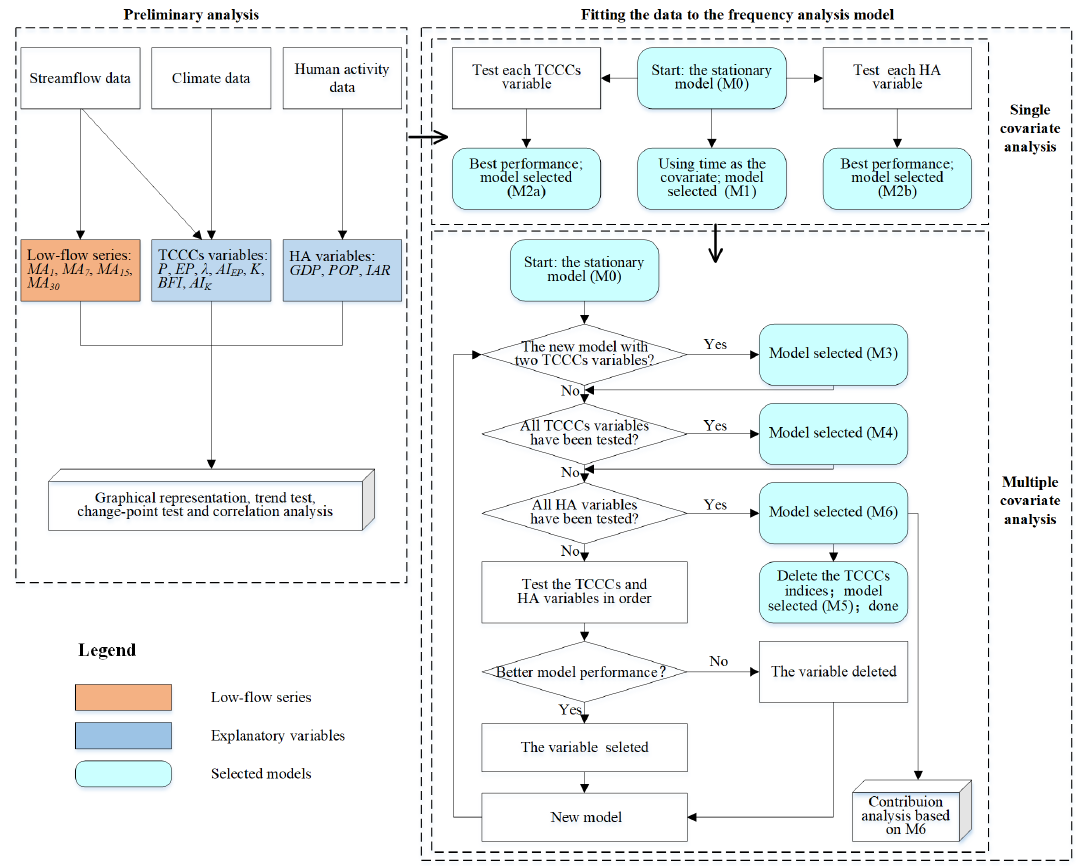
Figure 1. The framework of nonstationary low-flow frequency